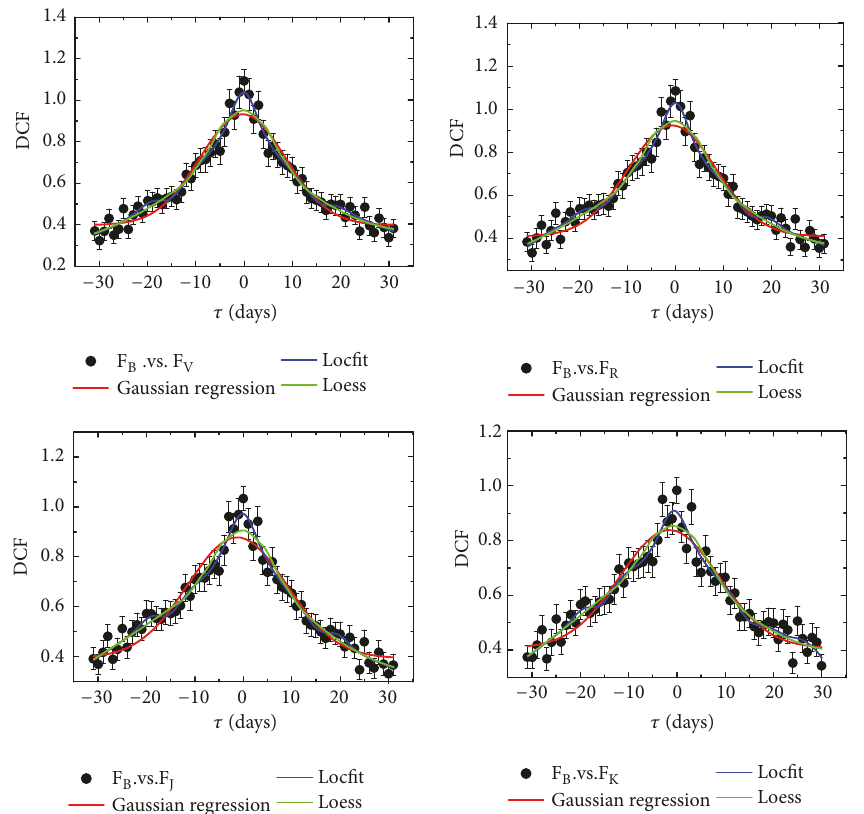
Figure 5: The time delays among the different bands. The red lines stand for the Gaussian fitting, the blue lines stand for Locfit regression, and green lines stand for Loess